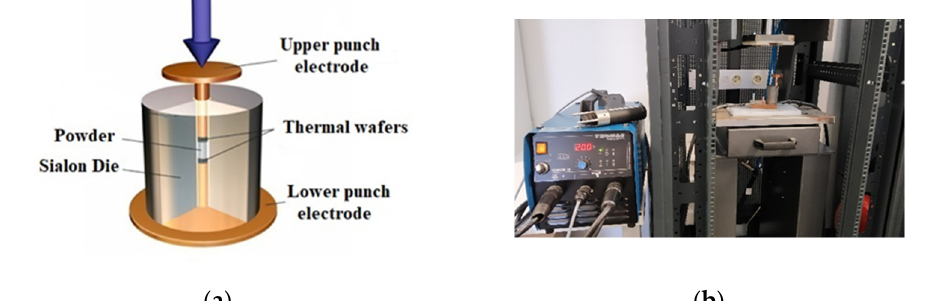
Figure 1. ( a ) Scheme of the sintering assembly, including electrodes and die, used in the CEDC experiments. ( b ) Stud welding equipment and pneumatic press used in the experiments.